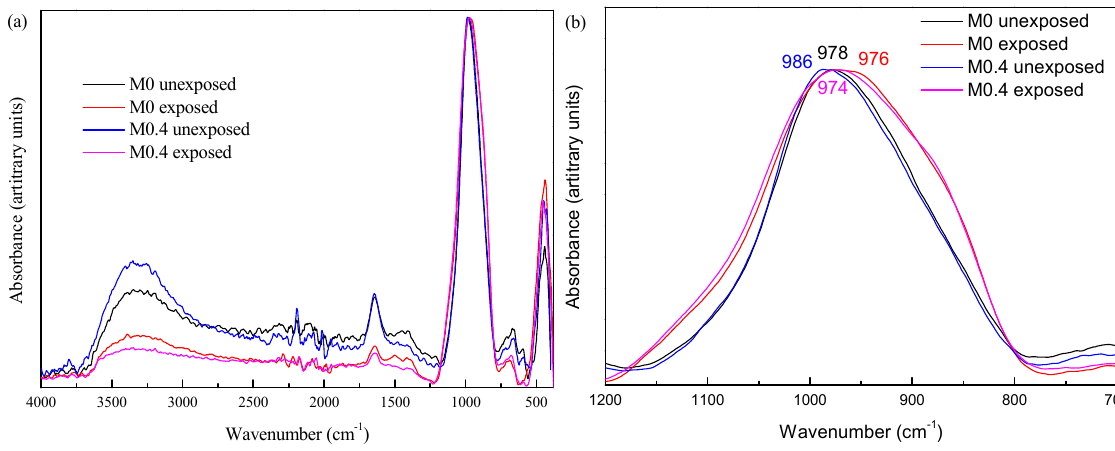
Figure 3. The FTIR spectra of AAM before and after exposure to sodium sulfate solution. ( a ) Full spectra; ( b ) zoom on the Si–O stretching band.